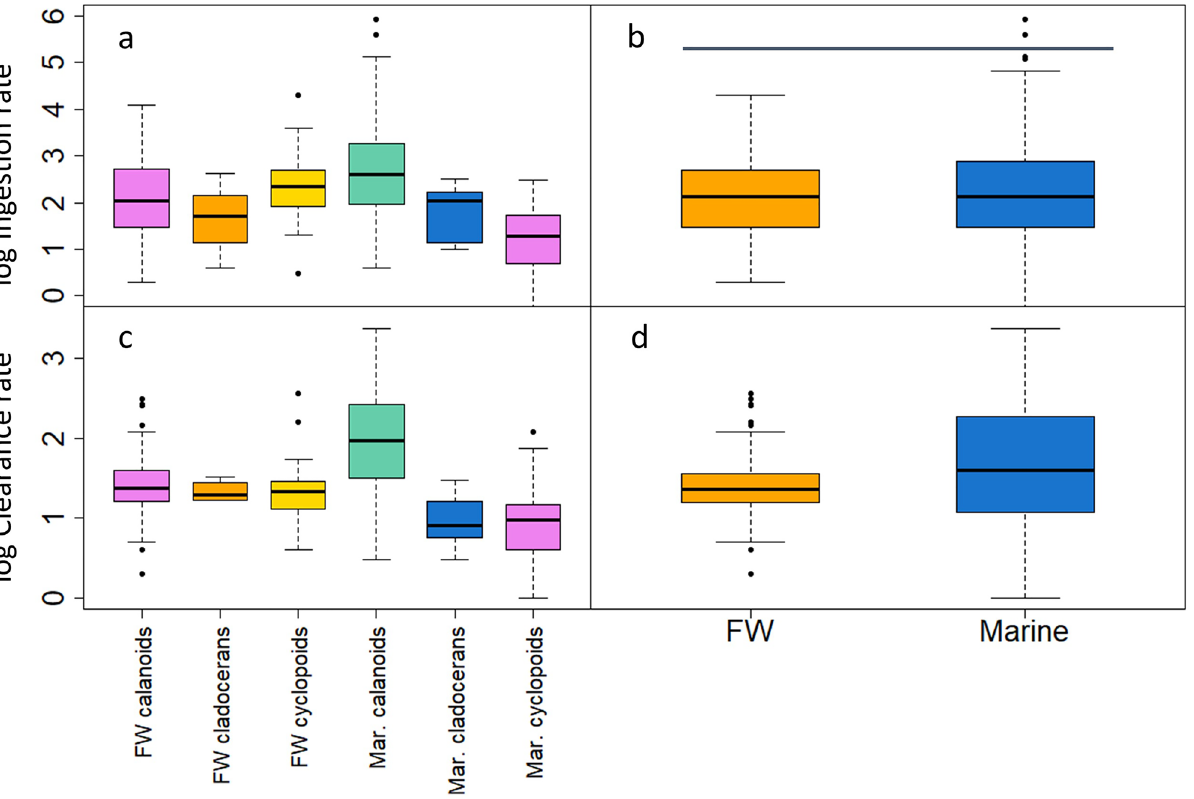
Figure 4. Log 10 –transformed ingestion rates (logIR, in ng C ind −1 d −1 , a , b ) and clearance rates (logCL, in mL individual −1 d −1 , c , d ) of major functional groups of microcrustaceans in freshwater (FW) and marine waters. In ( b ) and ( d ), all predators were combined for the two habitats. The horizontal bar in ( b ) indicates logIR of freshwater and marine predators were not significantly different from each other. Significant differences between individual functional groups ( a , c ) are reported in the text and Suppl. Table